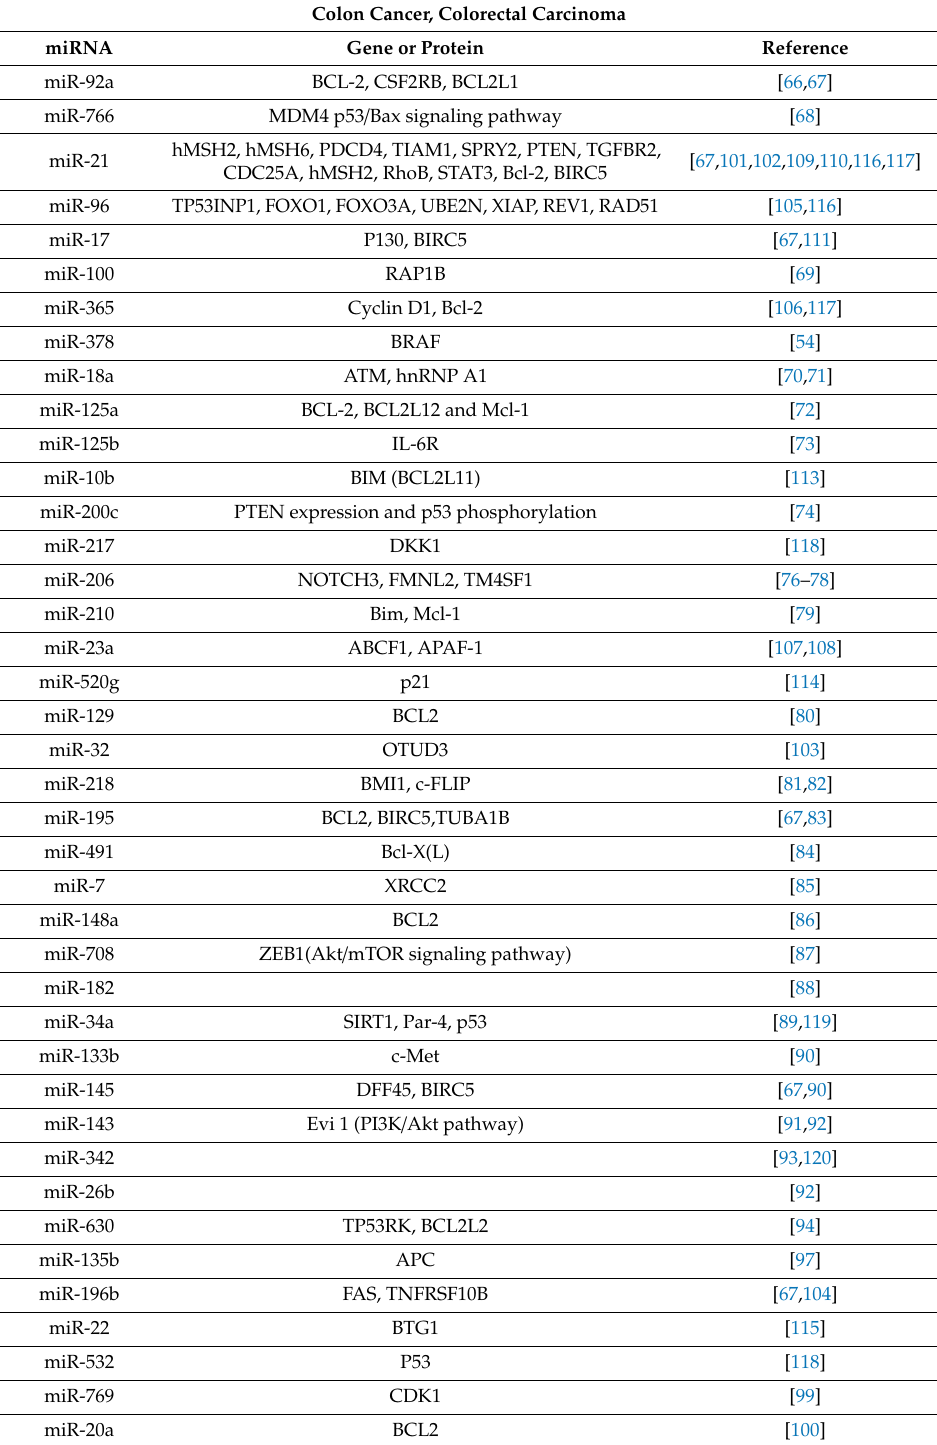
Table 1. miRNA mediates the apoptosis